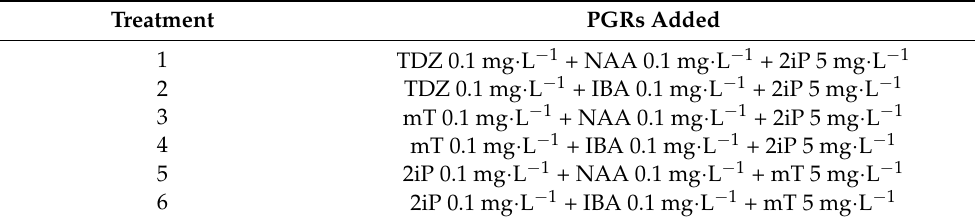
Table 7. Modifications of the MS medium used in the experiment.